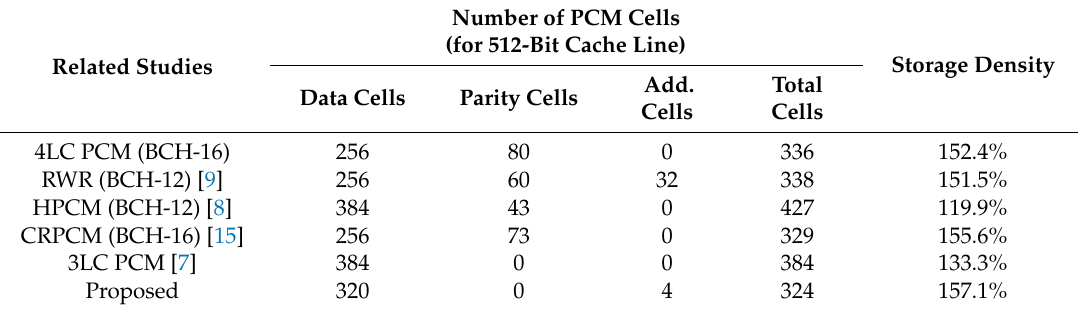
Table 7. Comparison of storage density between proposed method and previous studies.